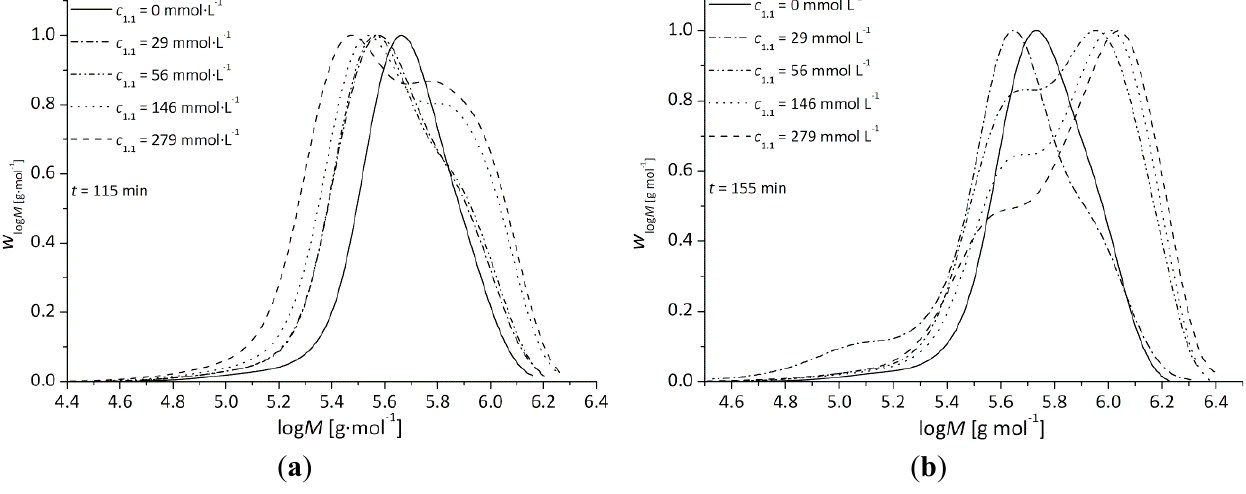
Figure 6. Corrected UV-SEC-traces of the aliquots quenched after 115 ( a ) and 155 min ( b ) of copolymerizations of BA and different amounts of 1.1 using 0.6 mmol·L − 1 R